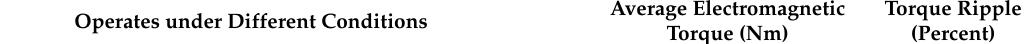
Average Electromagnetic Torque Torque (Nm)